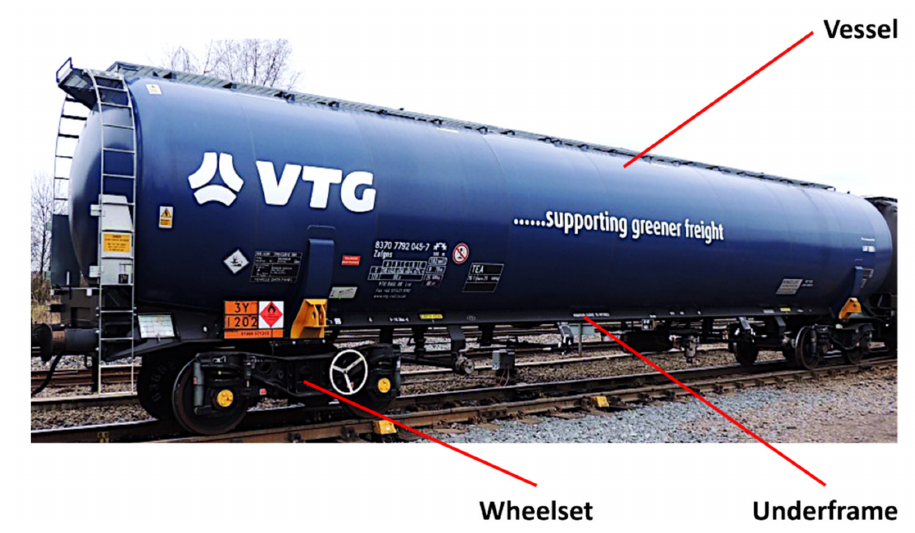
Figure 1. A typical petrochemical tank wagon (Source: Revolution